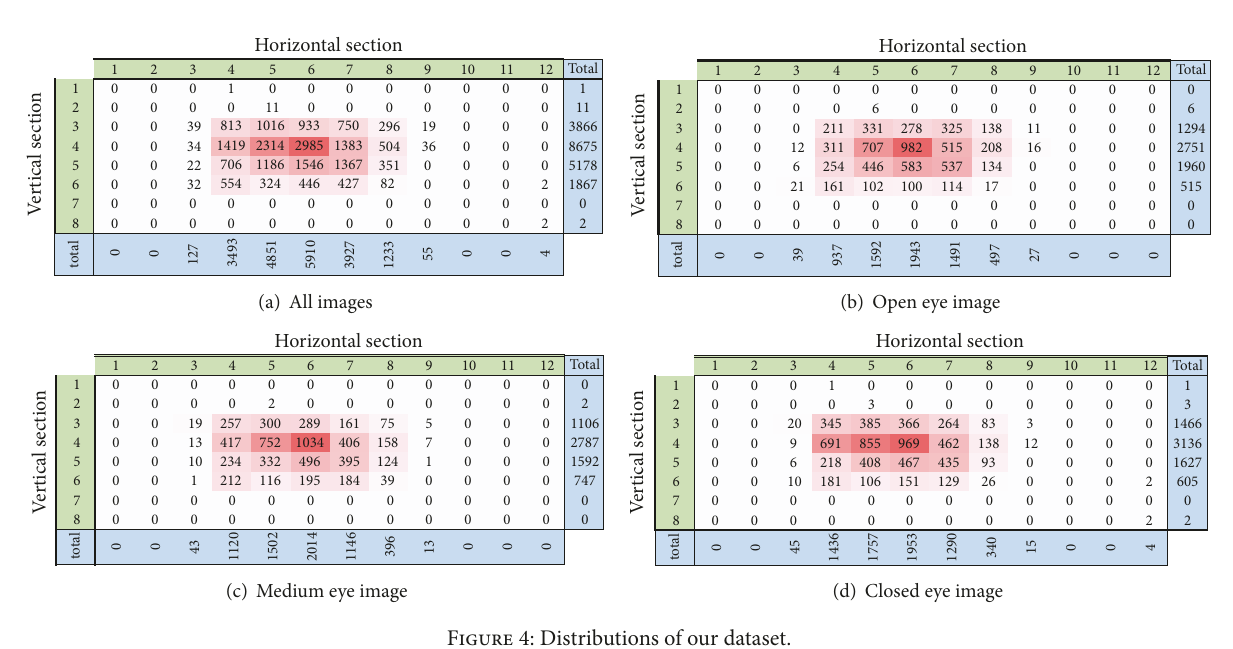
Figure 4: Distributions of our dataset.